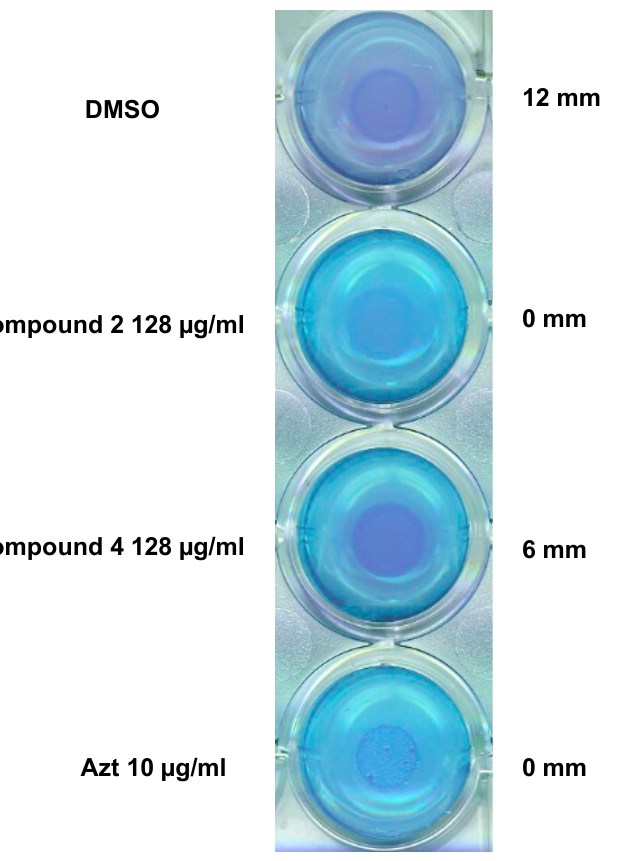
Figure 6. Effects of compounds 2 and 4 on rhamnolipids production. Compounds were tested in triplicate at a final concentration of 128 µ